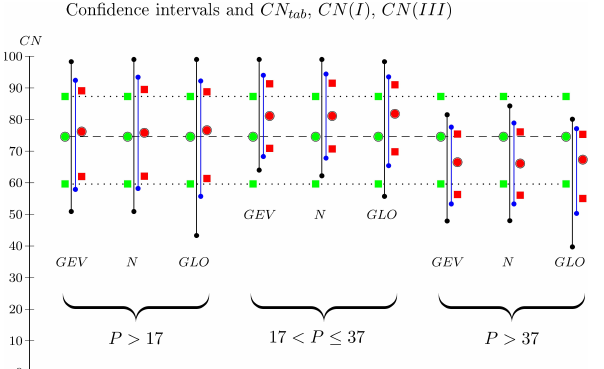
Figure 2. The tabulated CN (green circles), the medians (red circles), the CIs (99% (black lines), 95% (blue lines)), CN ( I ) , CN ( III ) (red lower and upper squares), and Hjel Hjel CN ( I ) , CN ( III ) (green lower and upper squares); the dashed line depicts the Haw Haw constant CN ; the dotted lines show CN ( I ) , CN ( III ) tab Haw Haw